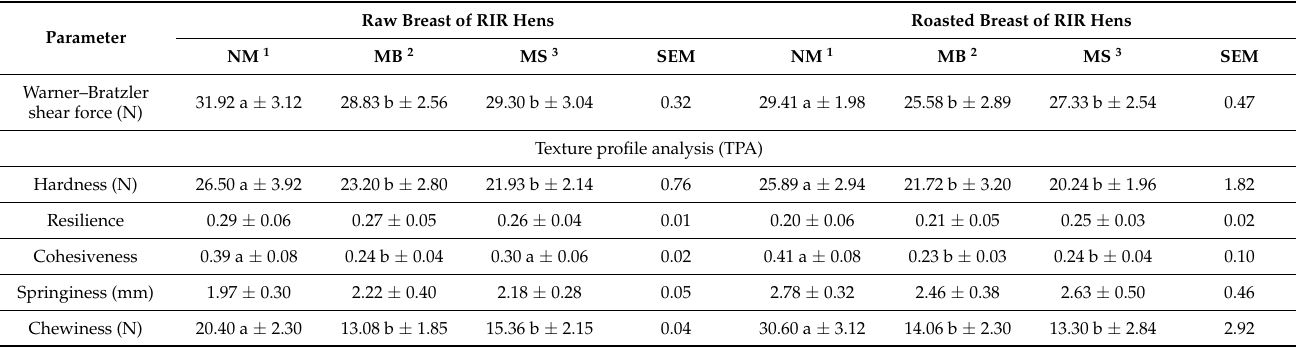
Table 2. Effect of marinating with fermented milk products on texture parameters (Warner–Bratzler, texture profile analysis) of raw and roasted hen breast